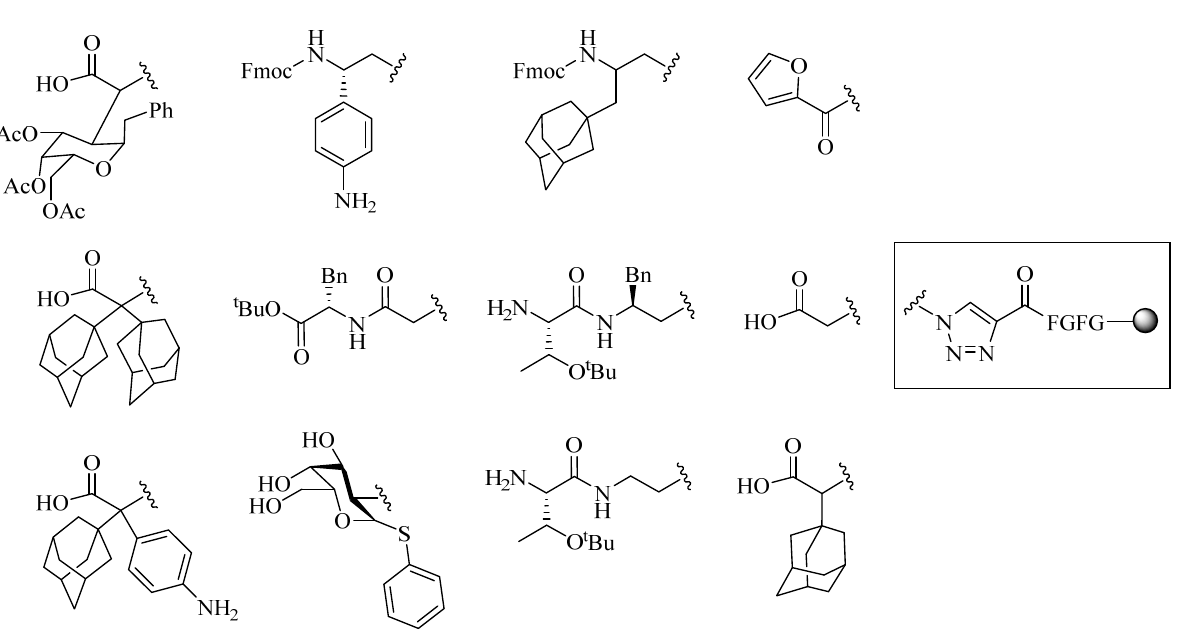
Figure 3. Examples of resin-bound peptidotriazoles constructs synthesized via